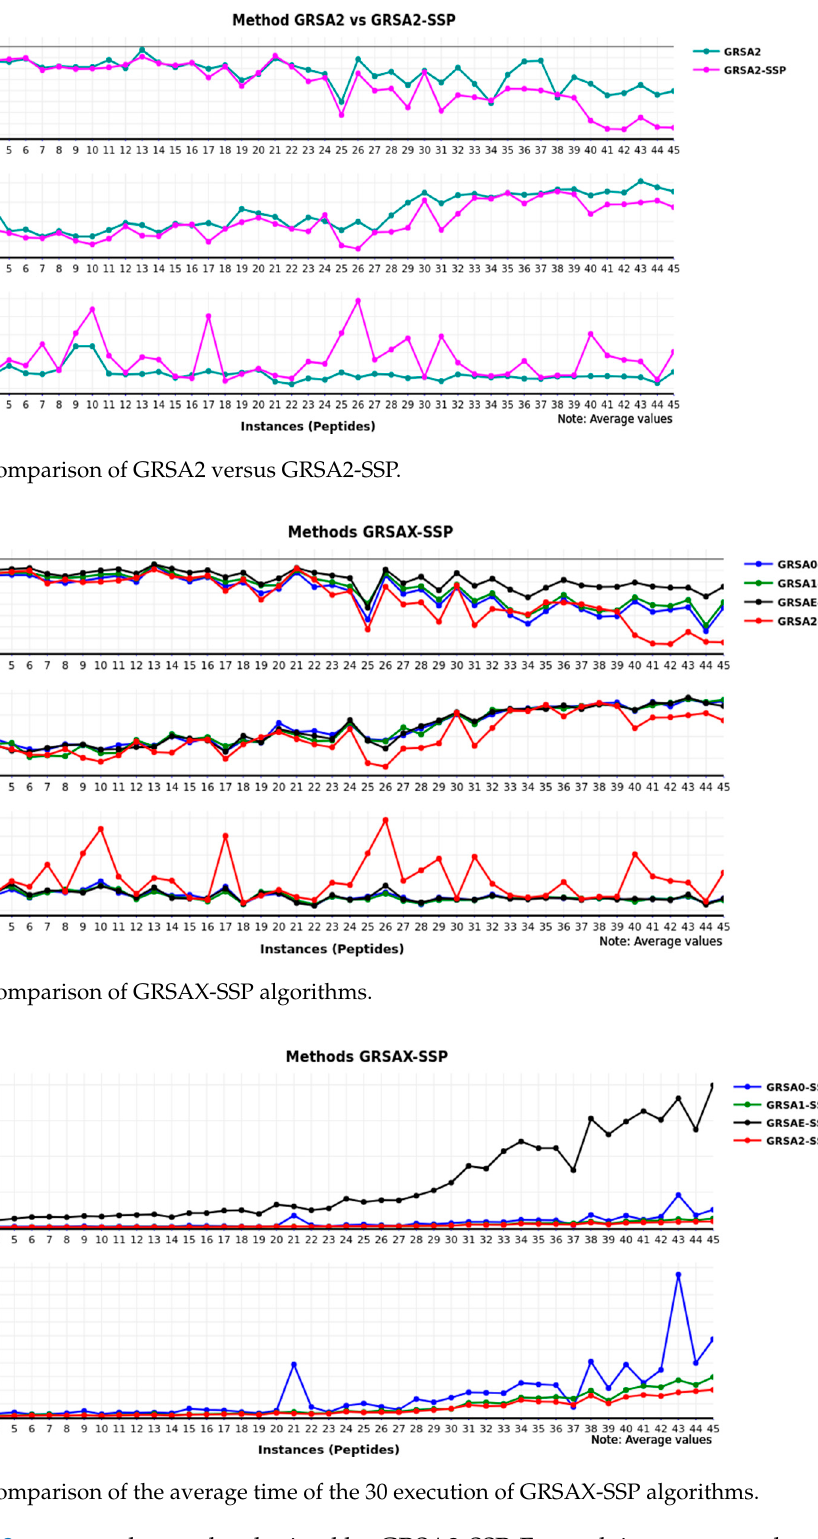
Figure 7. Comparison of the average time of the 30 execution of GRSAX-SSP algorithms.